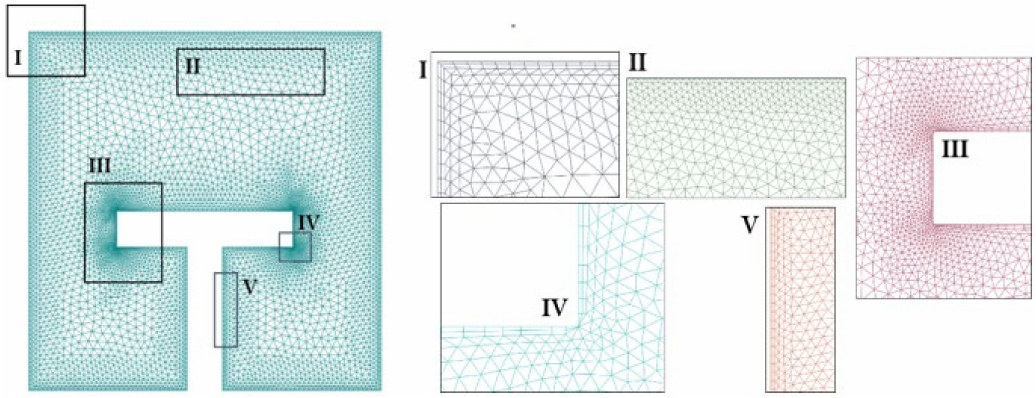
Figure 2. Mesh analysis at finer